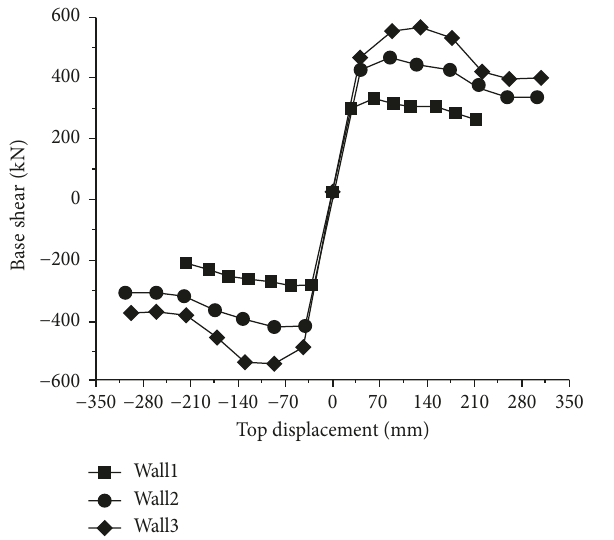
Figure 14: Base shear force-top displacement curves of the specimens.